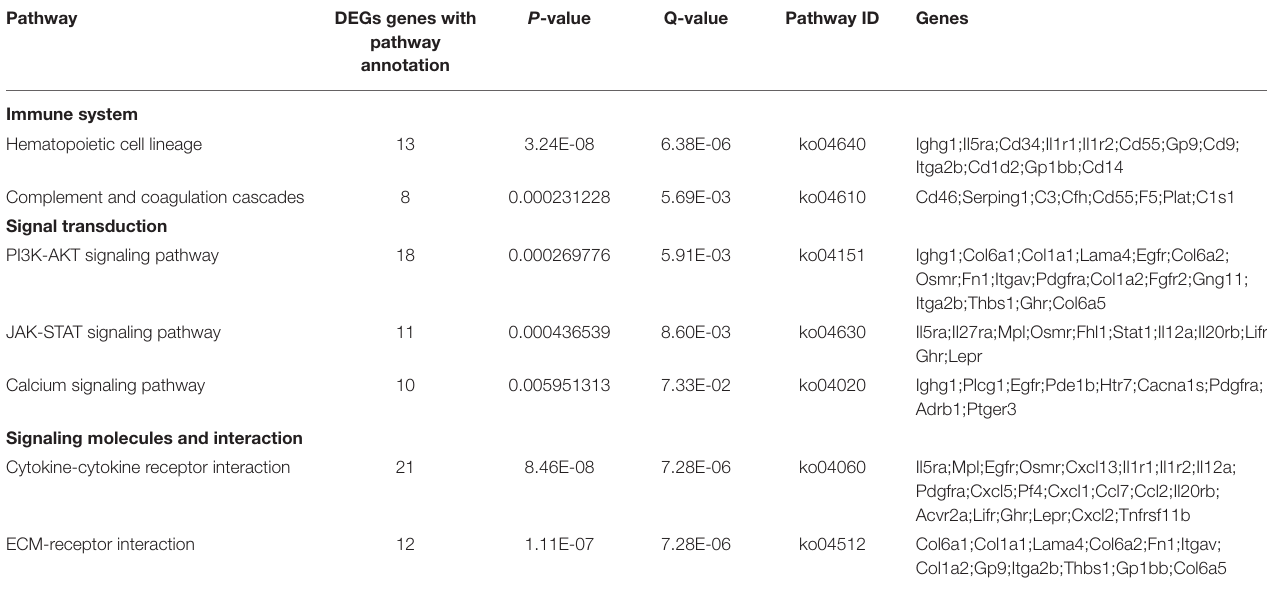
TABLE 2 | The KEGG pathways of differentially expressed